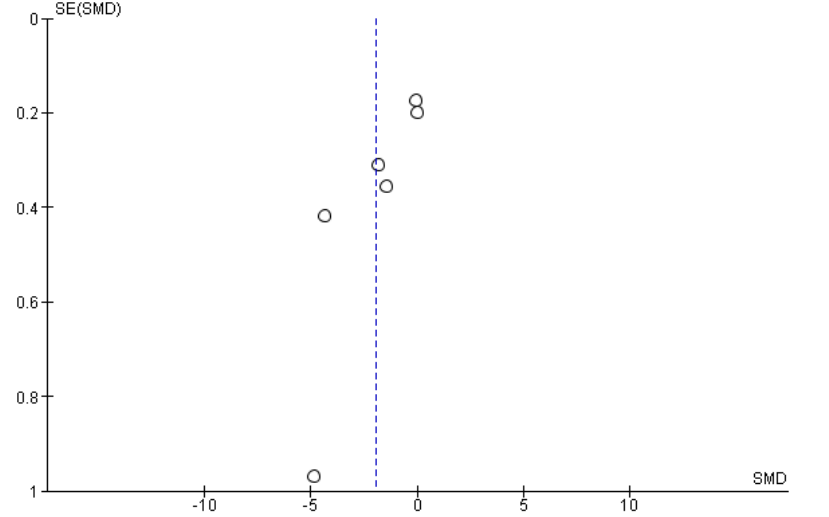
Figure 4. Funnel plot for publication bias assessment.